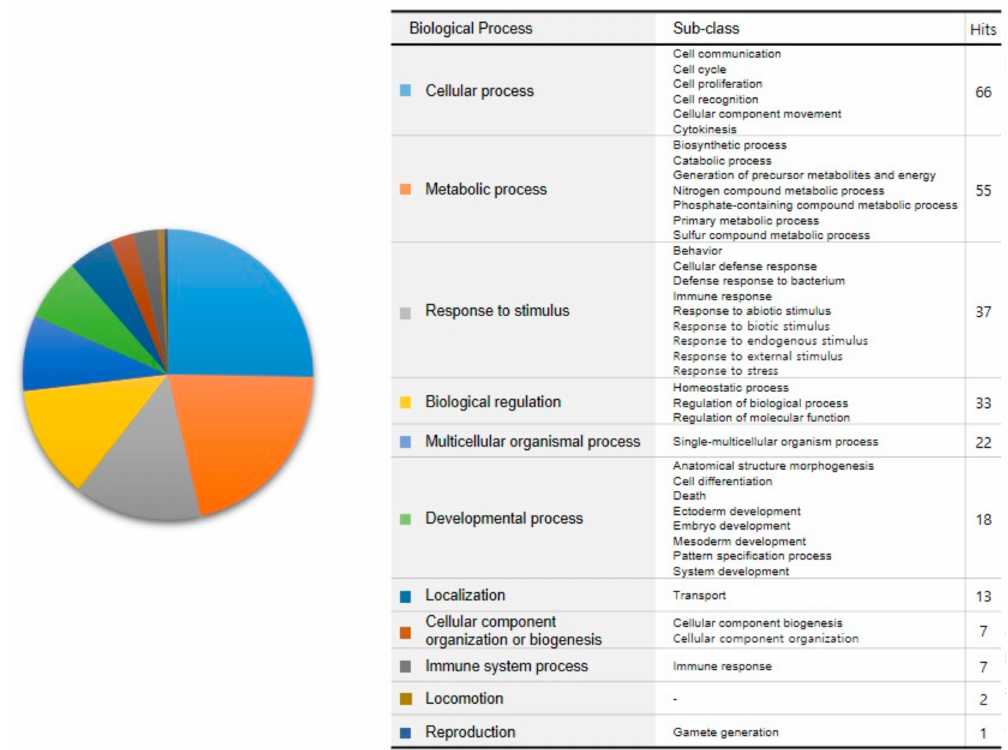
Figure 4. Biological processes related to targets of PG. Targets were assigned to biological processes using “Panther GO-slim Biological Process”. Hits mean the number of assigned targets to the corresponding biological processes. The proportion of each biological process is color-coded in the pie